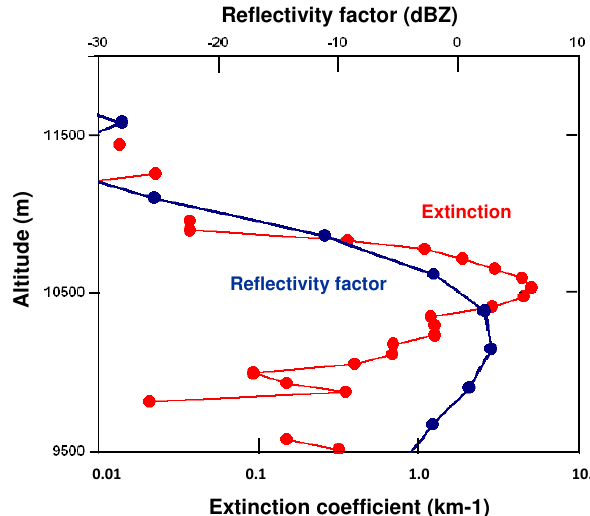
Fig. 2. Vertical profiles of the extinction coefficient and the reflec- tivity factor at the centre of the overshooting cell (48.97 ◦ N, see Fig. 1). 26 May 2007 cloud